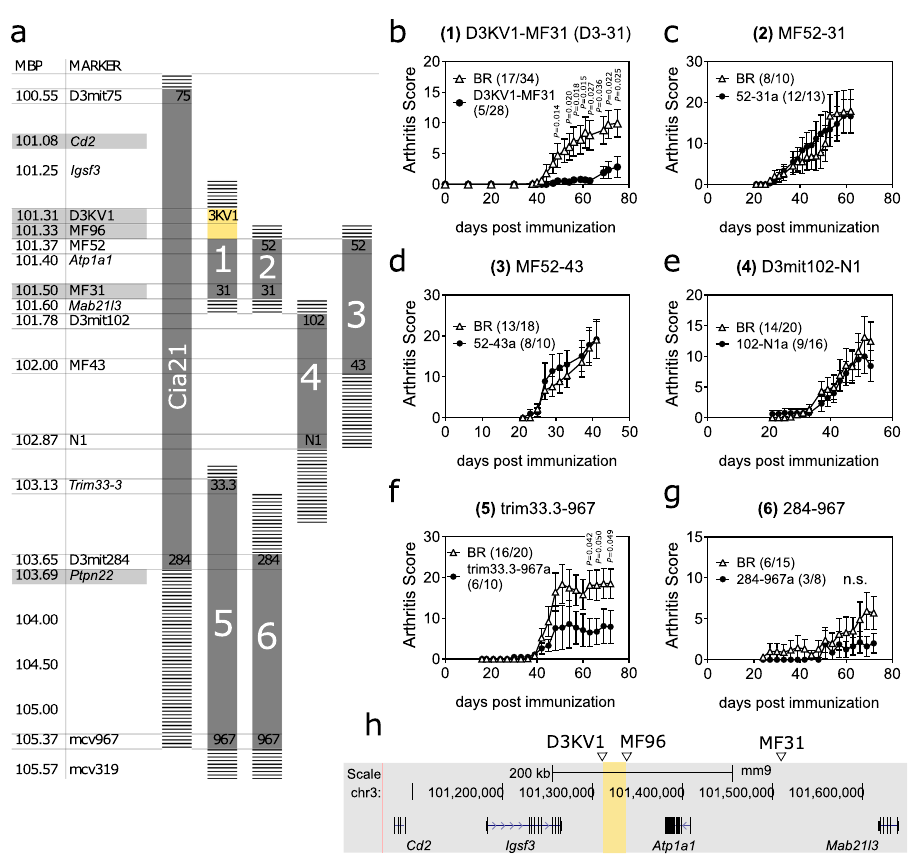
Fig. 1 Map of Cia21 QTL and critical D3KV1-MF31 interval. The Cia21 QTL resulted from an intercross between the CIA susceptible C57BL/10.RIII (BR) and the CIA-resistant RIIIS/J (R3) strains. Cia21 is present on chromosome 3 qF2.2 and is 3 Mbp in size. a Schematic representation of the Cia21 QTL and recombinant mice derived by intercrossing of Cia21 heterozygotes. Important genetic markers and genes are indicated on the left. The critical D3KV1- MF96 interval is highlighted in yellow. Uncertainty borders are dashed. b – g Collagen-induced arthritis in female recombinant mice from ( a ) compared to BR littermate controls. Incidence and total number of mice are indicated in parenthesis on the respective graphs. Data are summarised as mean (SEM). Statistical signi fi cance was evaluated using a two-tailed non-parametric Mann – Whitney U test. Data in each graph was pooled from two independent experiments. h Detailed view of D3KV1-MF31 (fragment 1, D3-31) and proximal genes. The critical D3KV1-MF96 interval is highlighted in yellow. Coordinates according to mouse NCBI37/mm9 build. n.s. not signi fi